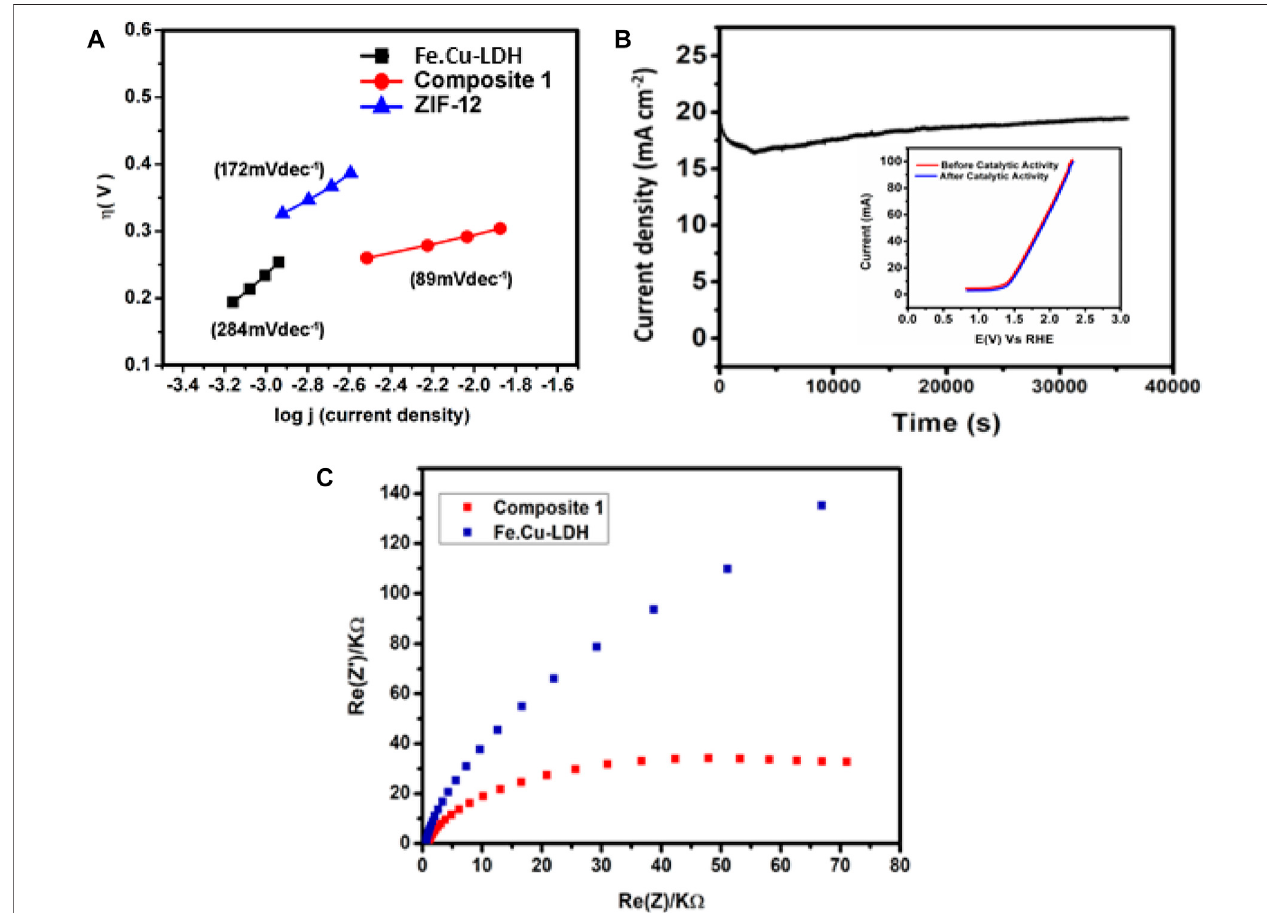
FIGURE5|(A) TafelslopsofFe.Cu-LDH,ZIF-12and 1 , (B) controlled-potentialelectrolysis(CPE)of 1 inbasicconditionsand (inset)LSvoltammograms ofpristine and post-catalysis of 1 modi fi ed FTO electrodes, and (C) electrochemical impedance spectra of non-faradaic region of 1 coated electrode recorded in KOH solution (1 mol L − 1 ) as an